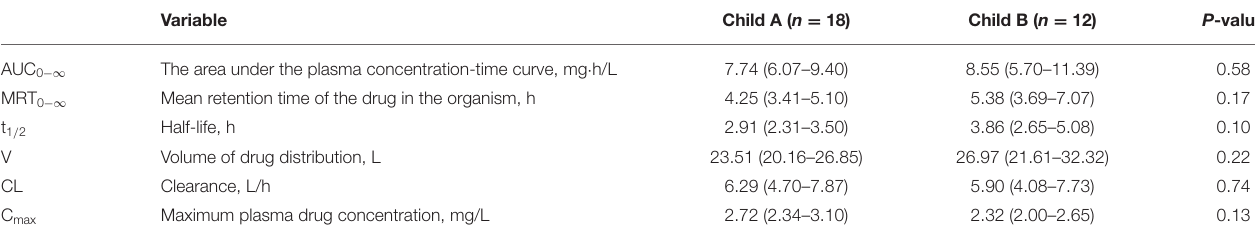
TABLE 4 | Comparison of esomeprazole pharmacokinetic parameters with various Child-Pugh grade. Variable